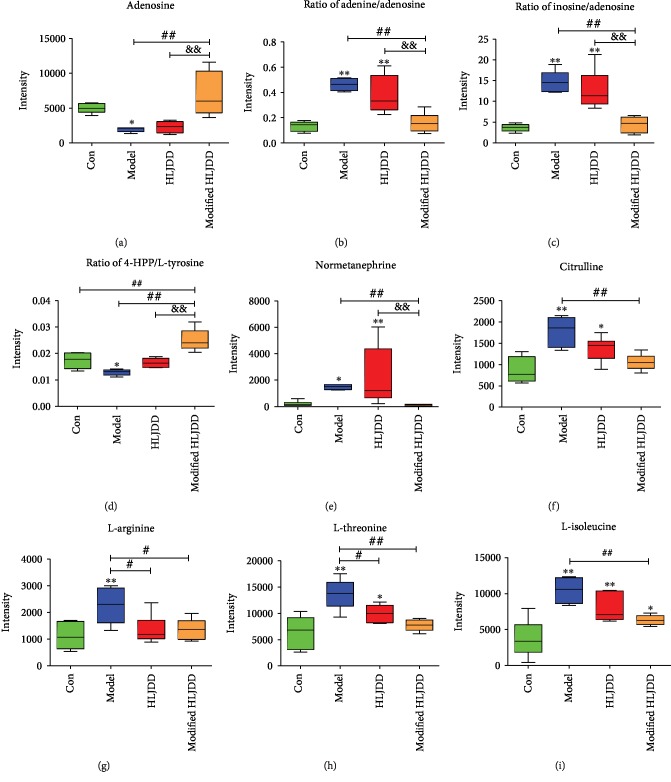
Differential metabolites upon HLJDD and modified-HLJDD treatments in an AD model. (a–i) Top-ranked differential metabolites among the four groups are shown. n = 6 for control, HLJDD, and modified-HLJDD groups. n = 5 for the AD model group. Results are expressed as the mean ± SEM. ∗∗p < 0.01, ∗p < 0.05 vs. control group; ##p < 0.01, #p < 0.05 vs. model group; and &&p < 0.01 vs. HLJDD group. Statistical significance was determined by one-way ANOVA and Bonferroni tests as post hoc comparisons.